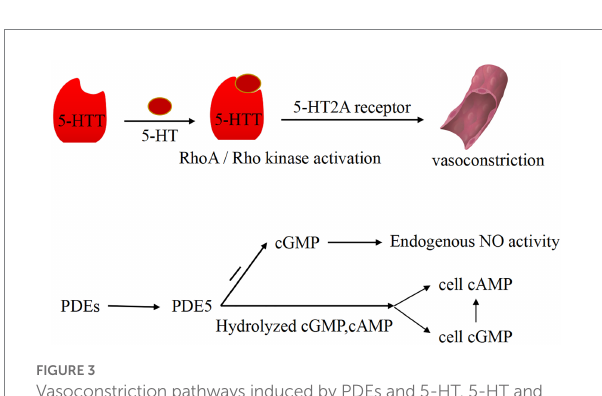
FIGURE 3 Vasoconstriction pathways induced by PDEs and 5-HT. 5-HT and 5-HT transporter (5-HTT) are involved in the activation of the RhoA/ Rho kinase pathway in phosphate smooth muscle cells. Under the action of 5-HTT and RhoA/Rho kinase, 5-HT binds to 5-HT2A receptor and induces vasoconstriction. PDE5 can degrade GMP, thereby reducing the activity of endogenous NO. In addition, PDE5 can hydrolyze intracellular cAMP and cGMP to regulate cAMP level through the high level of cGMP.